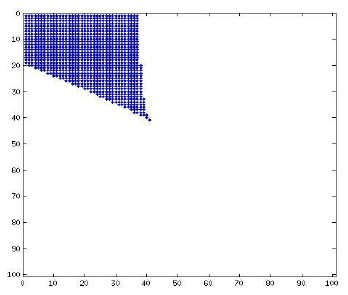
Figure 3. Matrix A of the Astrophysics application.